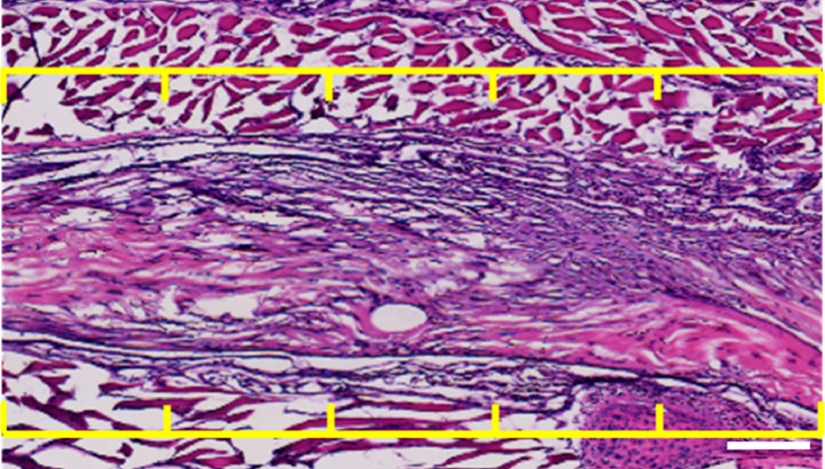
Figure A2. The histological evaluation standards for tendon adhesion. The histological scoring system of adhesions was scored in grades 0–10. The area was divided into 5 parts on both side of